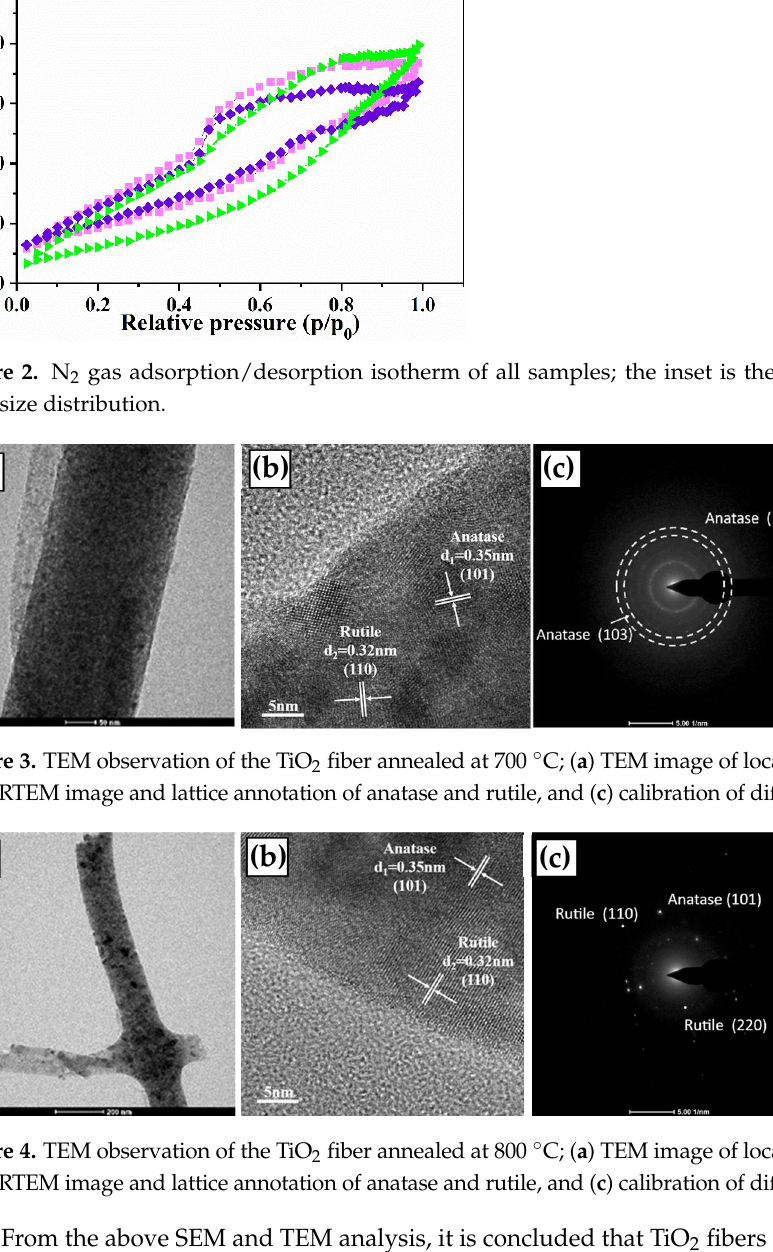
Figure 3. TEM observation of the TiO 2 fiber annealed at 700 °C; ( a ) TEM image of local magnifica- tion; ( b ) HRTEM image and lattice annotation of anatase and rutile, and ( c ) calibration of diffraction pattern.